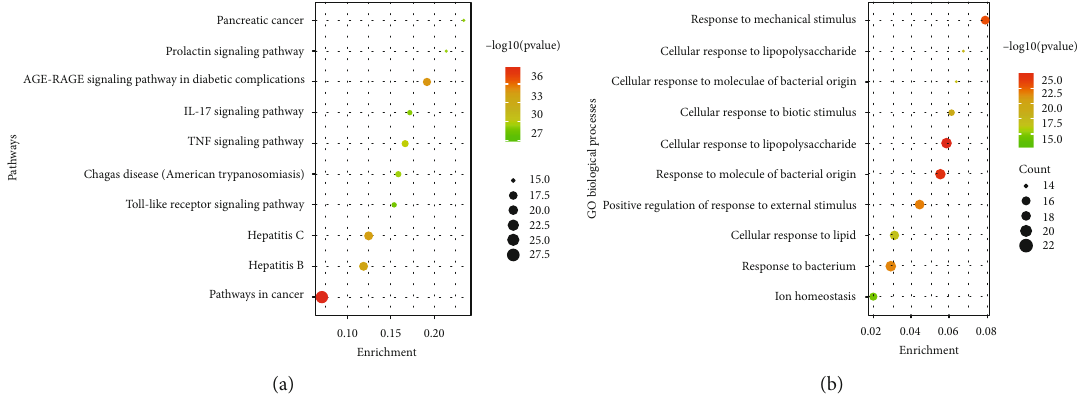
Figure 4: Bubble map of enrichment analysis: (a) KEGG enrichment analysis of Cap against acute lung injury (top 10 were listed); (b) GO enrichment analysis of Cap against acute lung injury (top 10 were listed).